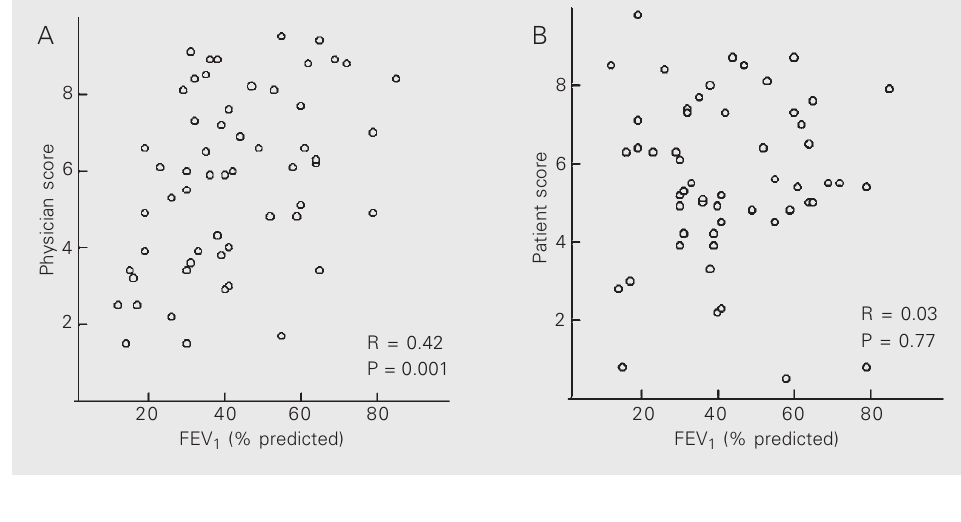
Figure 1. Relationship between severity scores of asthma exac- erbation evaluated by physi- cians (A) and patients (B) and forced expiratory volume at the first second (FEV 1 ; % pre- dicted). Scores range from 0 (more severe) to 10 (less se- vere). The correlation coeffi- cients, determined by the Spearman method, were 0.42